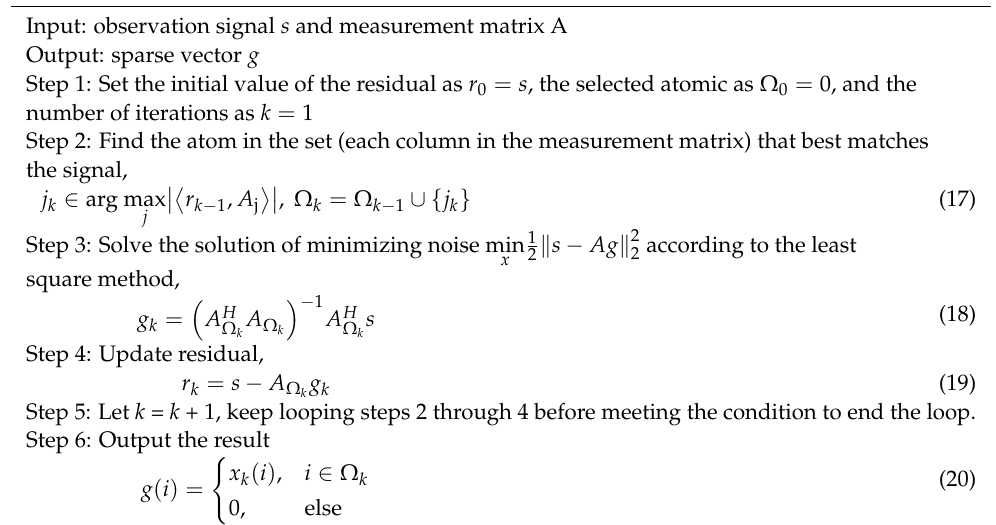
Algorithm 1. The Orthogonal Matching Pursuit